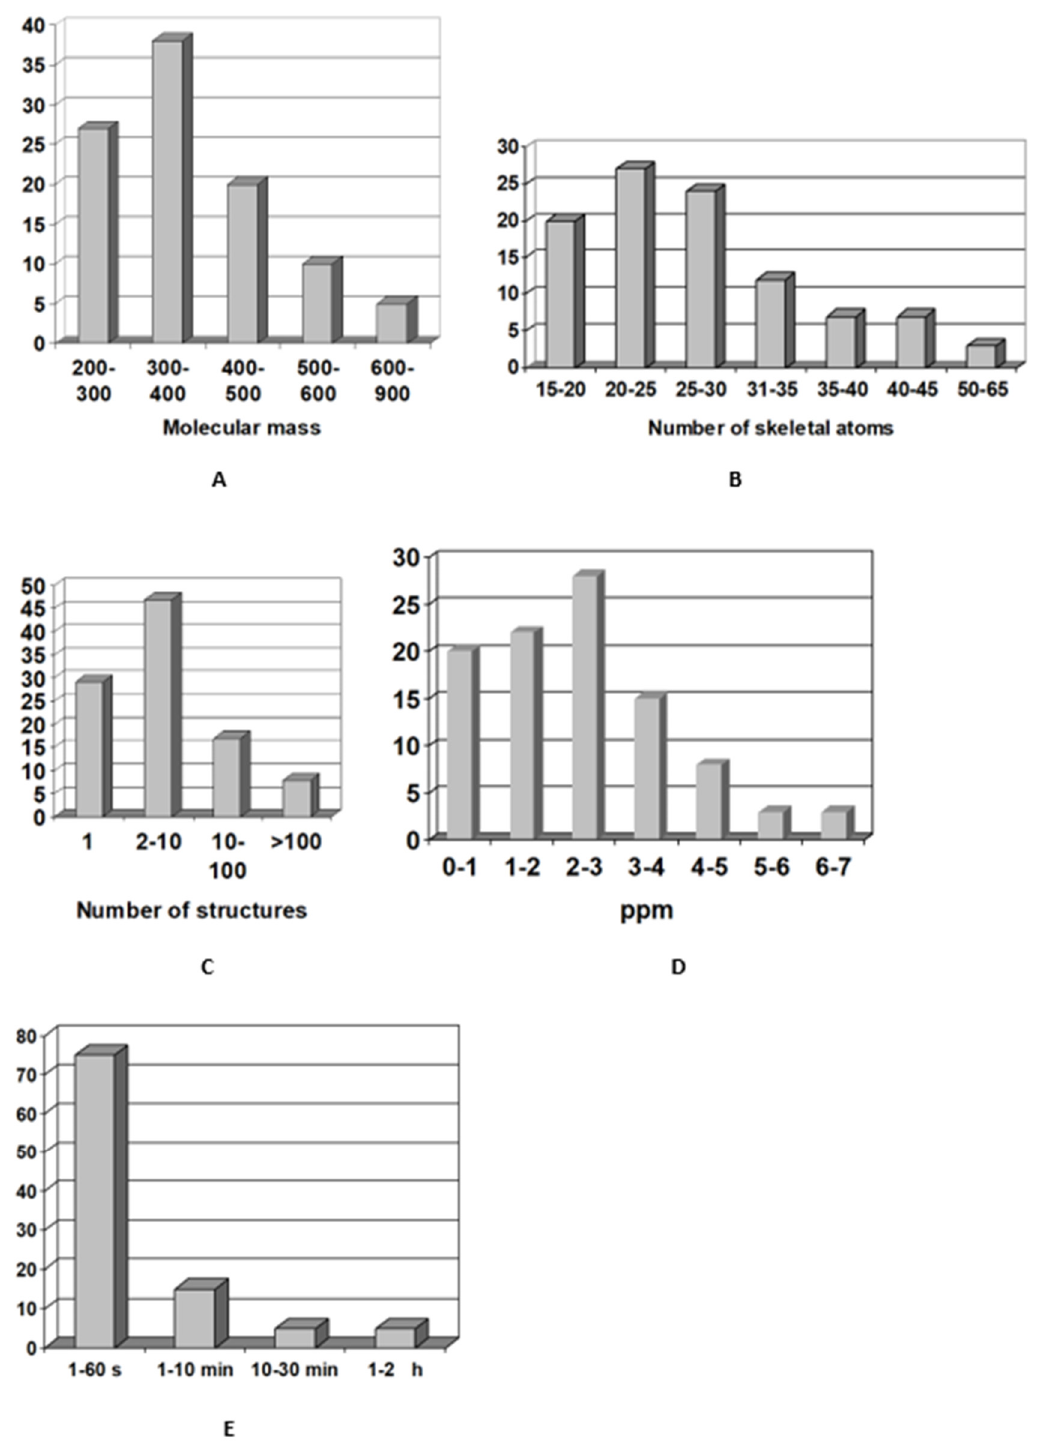
Figure 5. Results of the application of ACD/Structure Elucidator (ACD/SE) to structure elucidation: ( A ) Problem distribution (%) as a function of molecular mass. ( B ) Problem distribution (%) as a function of the number of skeletal atoms. ( C ) Problem distribution (%) with the value of d A (ppm) calculated for correct structures. ( D ) Problem distribution (%) as a function of the number of structures in the answer file. ( E ) Problem distribution (%) as a function of the time elapsed during structure generation.